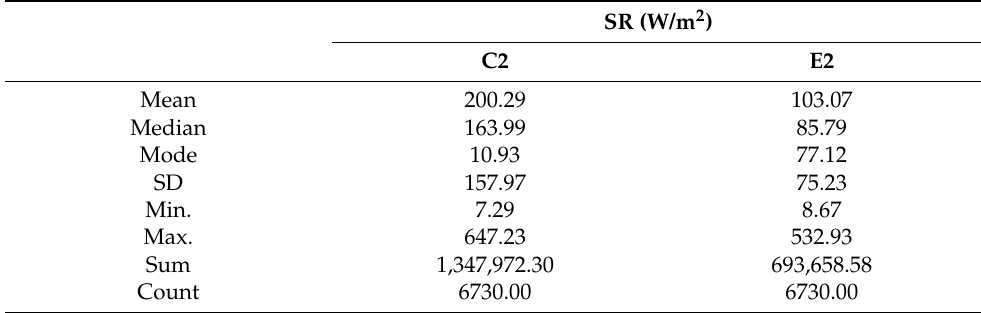
Table 3. Descriptive statistics of SR in SLG (single-layered greenhouse). SR: solar radiation; C2 and